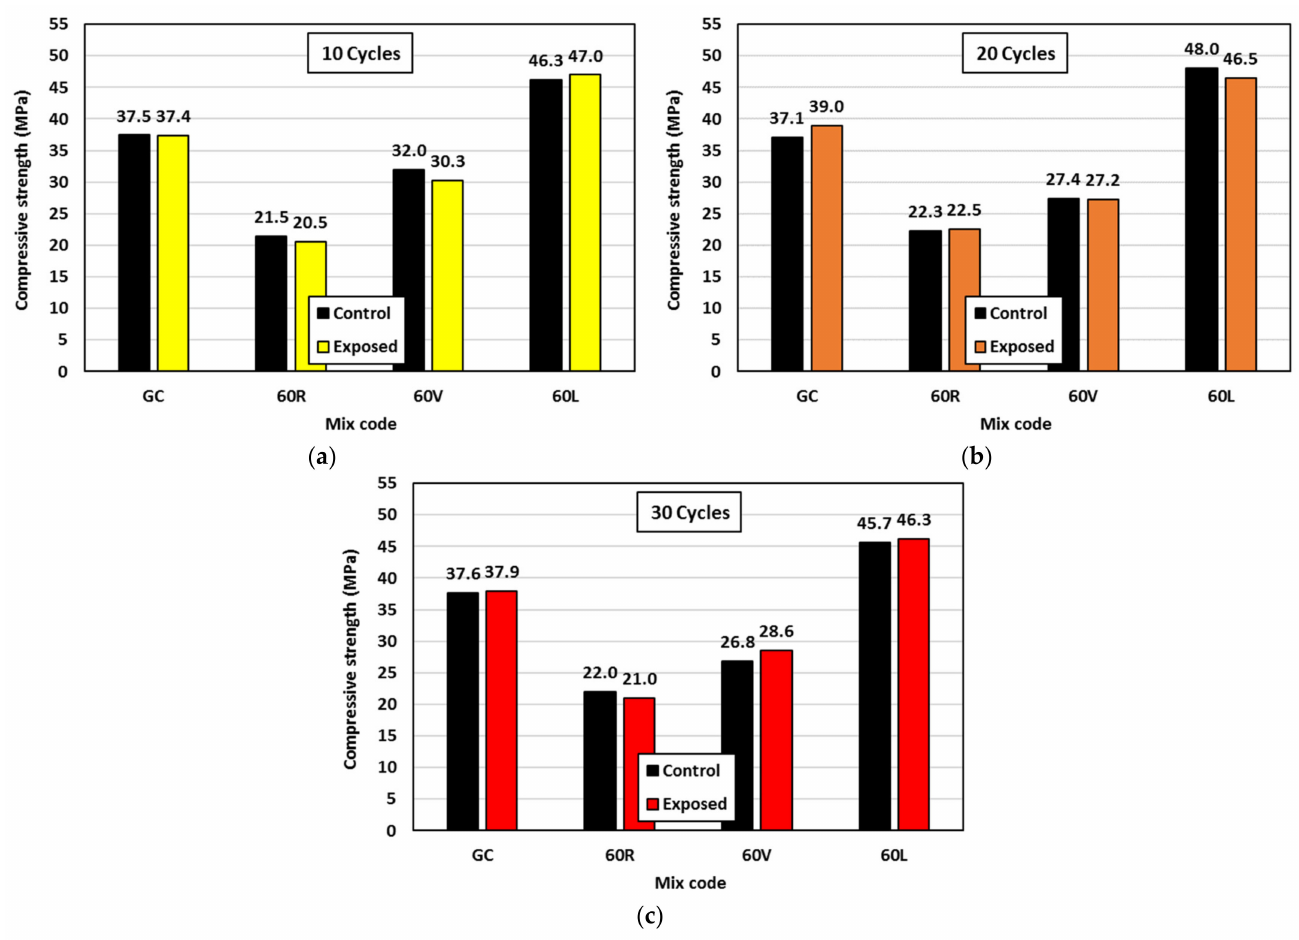
Figure 10. Effect of freezing-thawing cycles on geopolymer concrete 100 mm3 cube compressive strength: ( a ) 10 cycles, ( b ) 20 cycles, and ( c ) 30